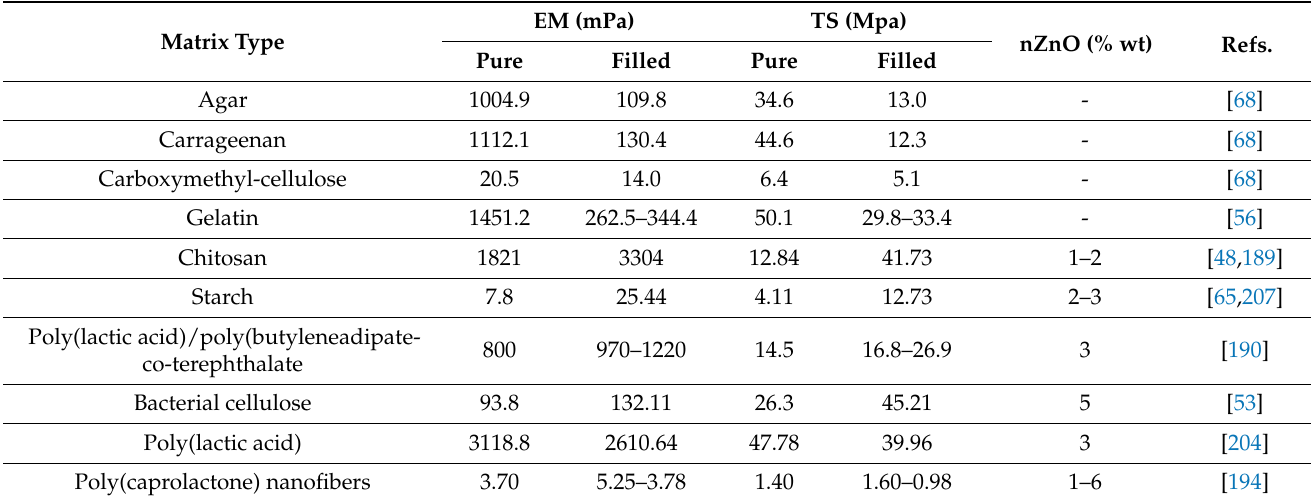
Table 2. Effect of nZnO on the elastic modulus (EM) and tensile strength (TS) of films.